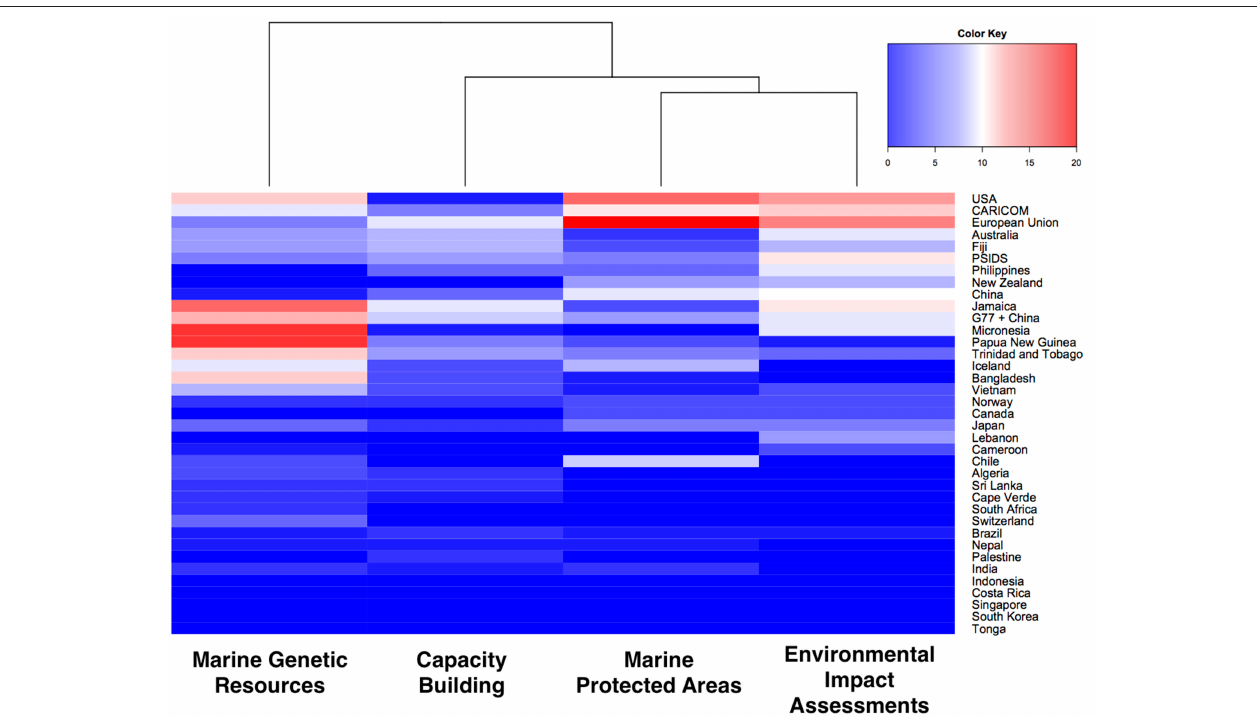
FIGURE 5 | Overall frequency with which package elements were identified by States and Groups in official statements during first meeting of the preparatory committee on biodiversity in areas beyond national jurisdiction, with overarching cluster